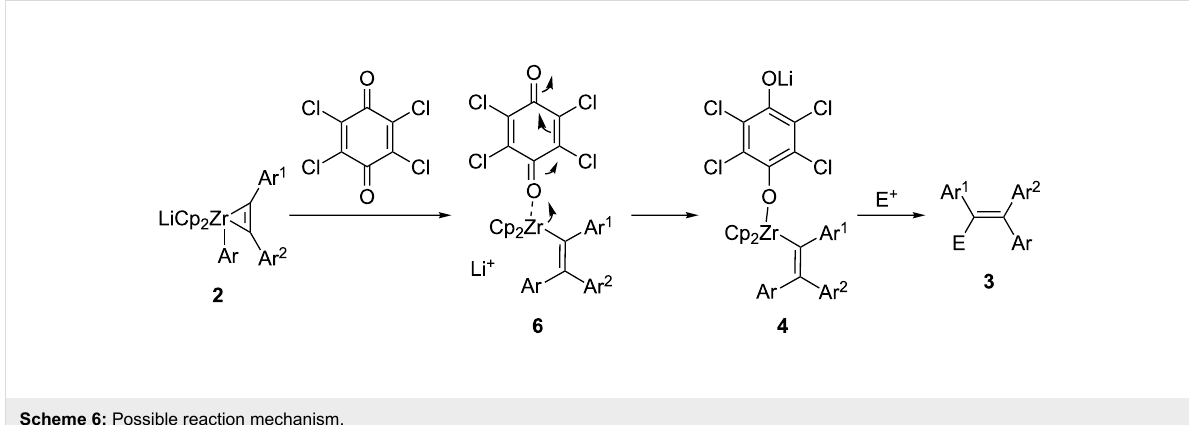
Scheme 6: Possible reaction mechanism.